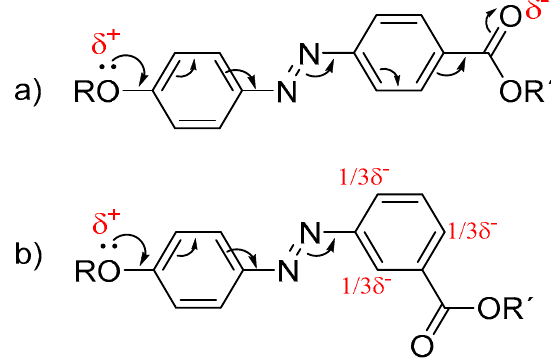
Figure 10. Conjugation possibilities of (a) 4-((4 ′ -hydroxyphenyl)diazenyl)benzoic acid derivatives and (b) 3-((4 (cid:48) -hydroxyphenyl)diazenyl)benzoic acid